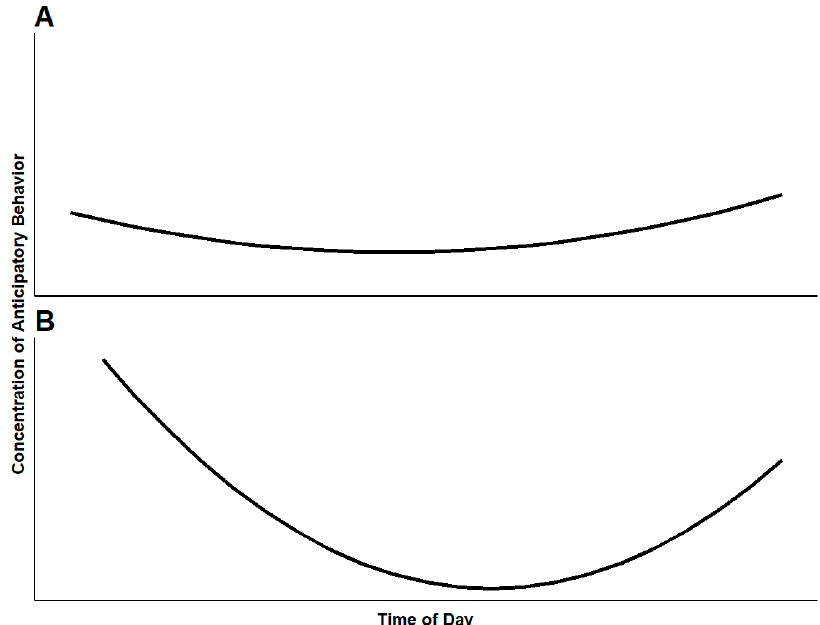
Figure 2. Concentration of anticipatory behavior expressed by animals living in ( A ) a high quality environment with numerous positive opportunities available throughout the day and ( B ) a low quality environment with positive opportunities only early and late in the day. This model assumes caretakers provide routine husbandry (feed and enrichment) at least twice early and late in the day, but in ( A ) caretakers provide more opportunities in addition to routine servicing spread throughout the day.